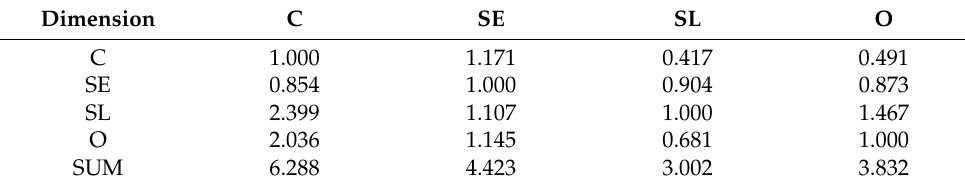
Table 8. The non-fuzzy comparison matrix of the AHP-SF model.